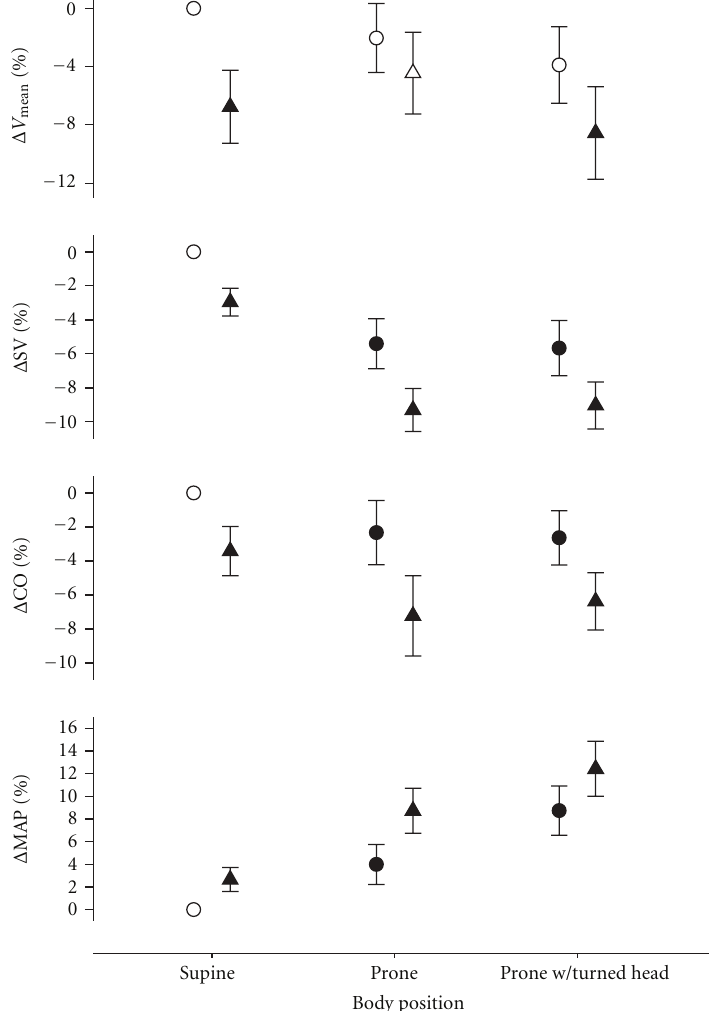
Figure 1: Systemic and cerebral circulatory responses to continuous positive airway pressure (CPAP) at di ff erent body positions. Changes in middle cerebral artery mean blood velocity ( Δ MCA V mean ), mean arterial pressure ( Δ MAP), cardiac stroke volume ( Δ SV), and cardiac output ( Δ CO) during CPAP 0cmH 2 O (circles), and 10cmH 2 O (triangles). A filled circle indicates a statistically significant di ff erence from supine. A filled triangle indicates a statistically significant e ff ect of 10cmH 2 O